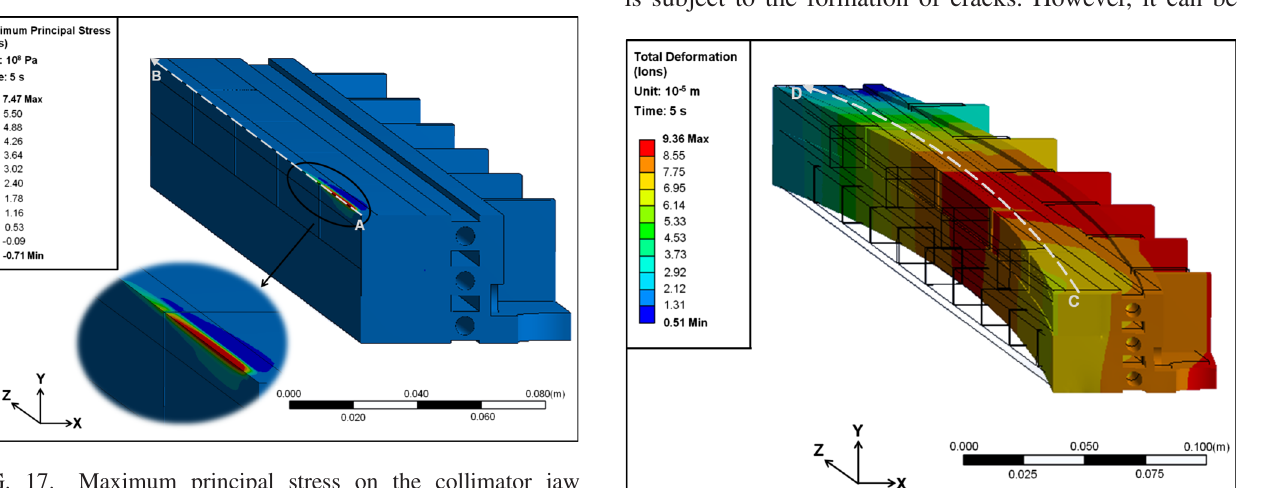
FIG. 17. Maximum principal stress on the collimator jaw assembly as provoked by the ion (1 nominal ion bunch) beam impact. The red region indicates the region of the jaw where the UTS of INERMET ® 180 is exceeded, leading to the formation of micro-cracks and ultimately, spallation.